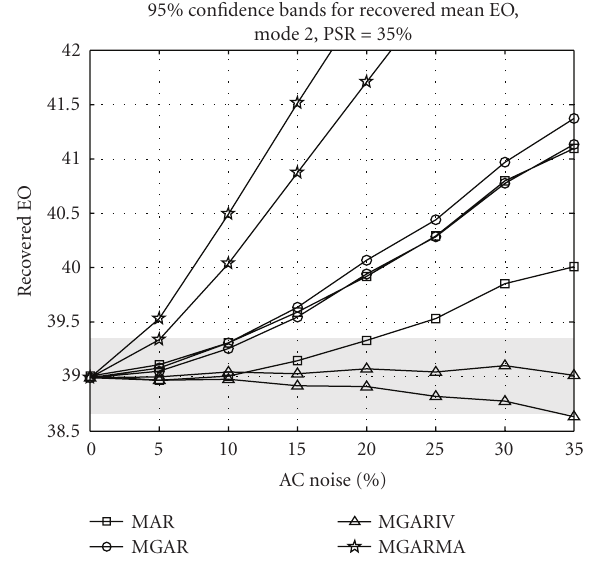
Figure 10: Test 2: 95% confidence bands for Prony-based methods, mode 2.